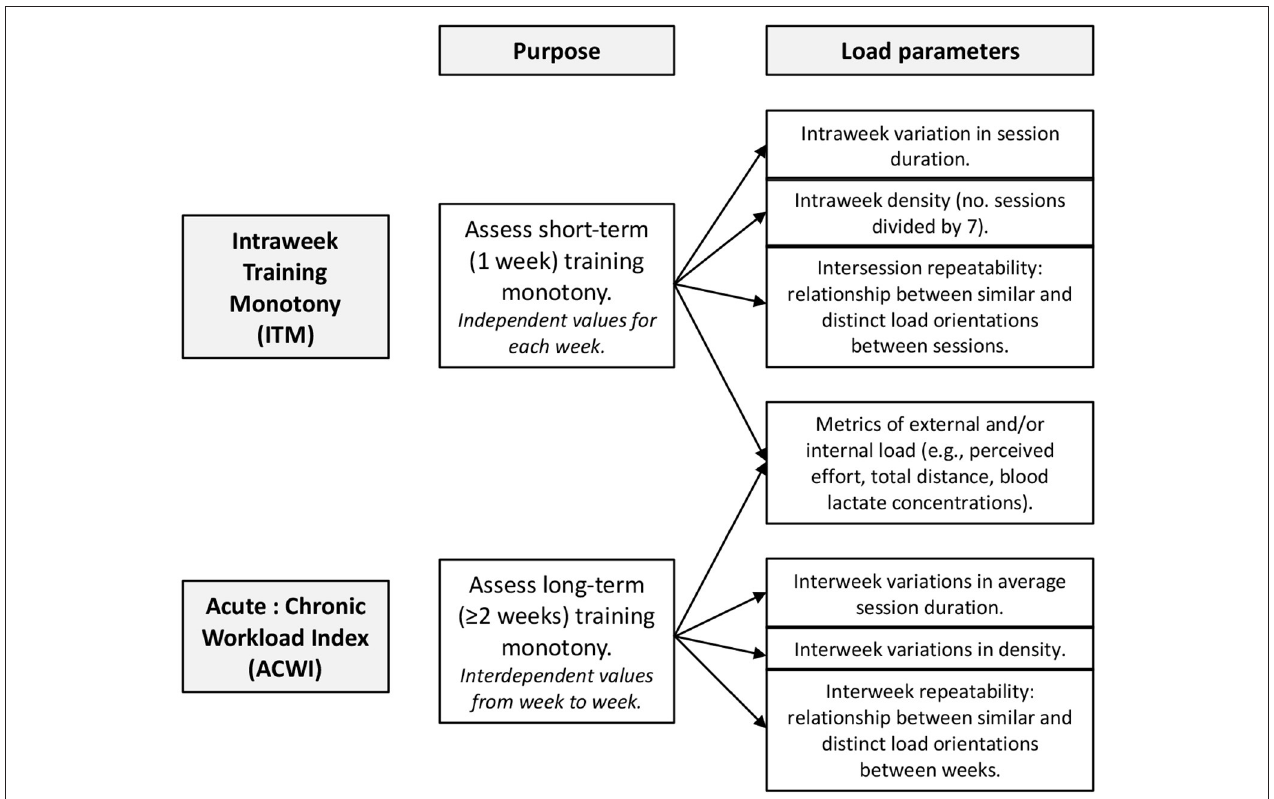
FIGURE 1 | Conceptual models for Intraweek Monotony Index (ITM) and Acute:Chronic Workload Index.